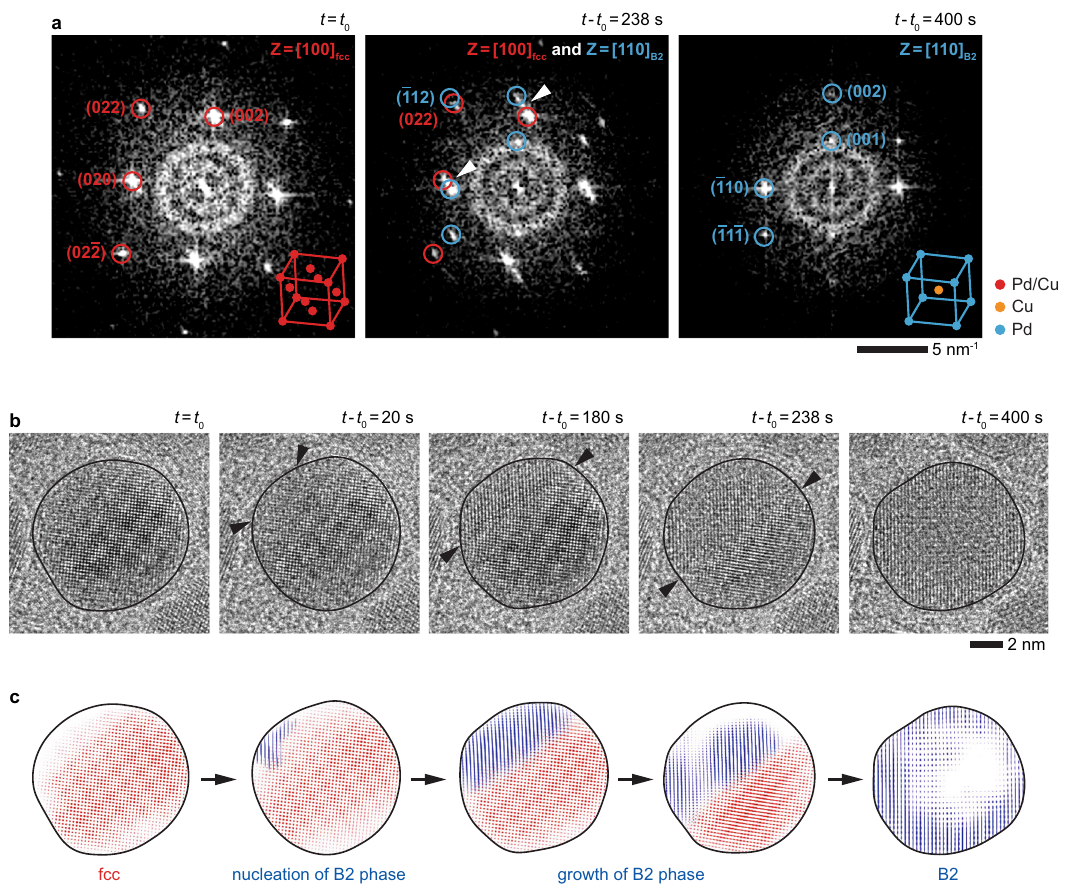
Fig. 1 | Phase transition of an fcc PdCu alloy NP into a B2 NP. a FFT and b TEM black arrows in b indicate the locations of the moving fcc − B2 interface during heating. c Sequence of inverse FFT images corresponding to the image series in image series of a disordered fccPdCu NPtransforming into a B2(i.e., ordered bcc) b identifying thefcc(red)andB2(blue) regions during the NP transformation. t 0 is zone axes (Supplementary NP at 500°C when viewed from 100 ½ (cid:2) fcc and 110 ½ (cid:2) B 2 Movie 1). The insets in a show schematics of fcc ( t = t 0 ) and B2 ( t − t 0 =400s) unit the timepoint at which we started recording the cells.Thewhitearrowsin a pointtothetracesconnectingthefccandB2spots.The